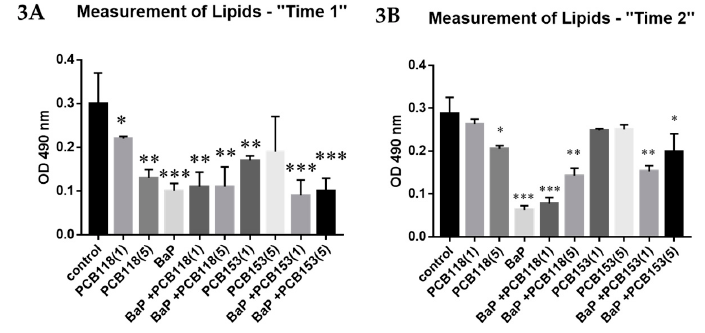
Figure 3. Effects of PCB118, PCB153 and BaP on “Oil Red O” staining of adipocytes (( A ) “Time 1”;